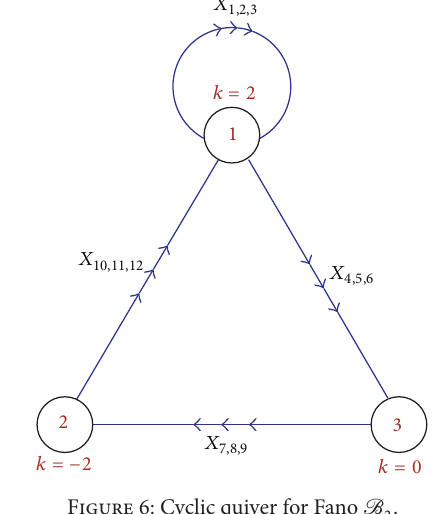
Figure 6: Cyclic quiver for Fano B 2 .